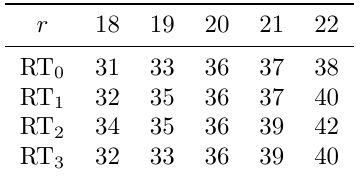
Table 4: The minimum number of active S-boxes and the maximum EDP for the related- tweak differentials within the activity patterns with the minimum (or close to the minimum) number of active S-boxes. Note that RT i refers to the characteristic starting with round round 4 · j + i , and also, we use p = − log EDP instead of showing the value for EDP. 2 minimum number of active S-boxes highest expected differential